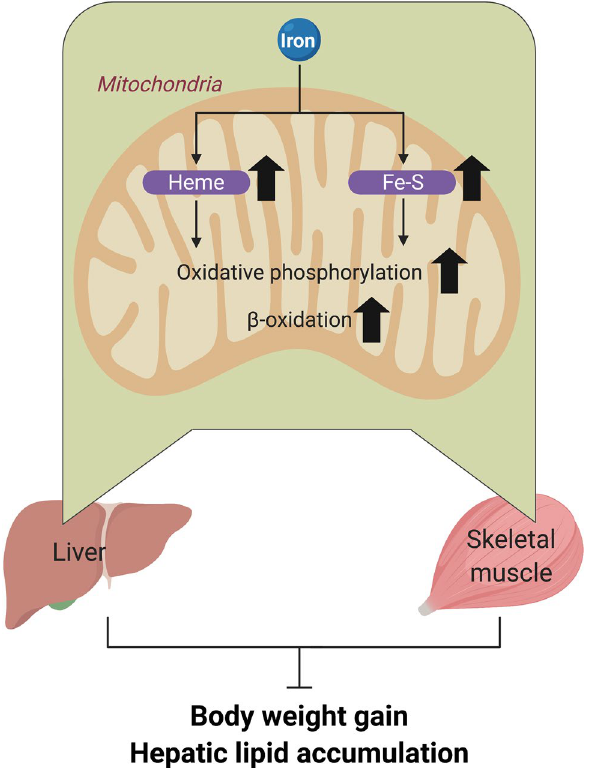
Figure 8. Suggested mechanism for the reduction in diet-induced weight gain and hepatic lipid accumulation by iron